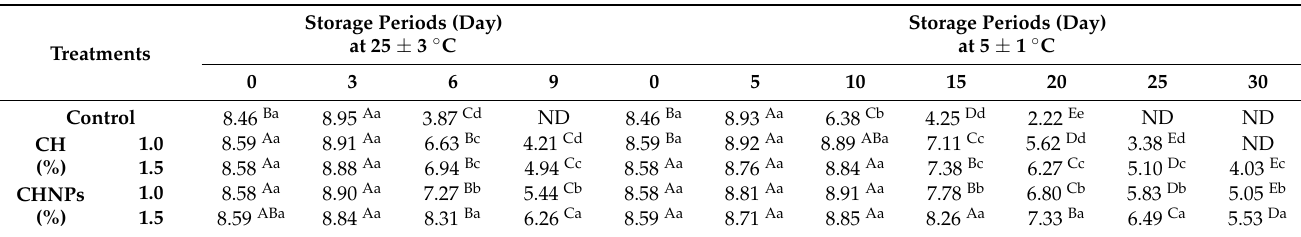
Table 6. Effect of the coating treatments on the overall quality of the apricots during storage.